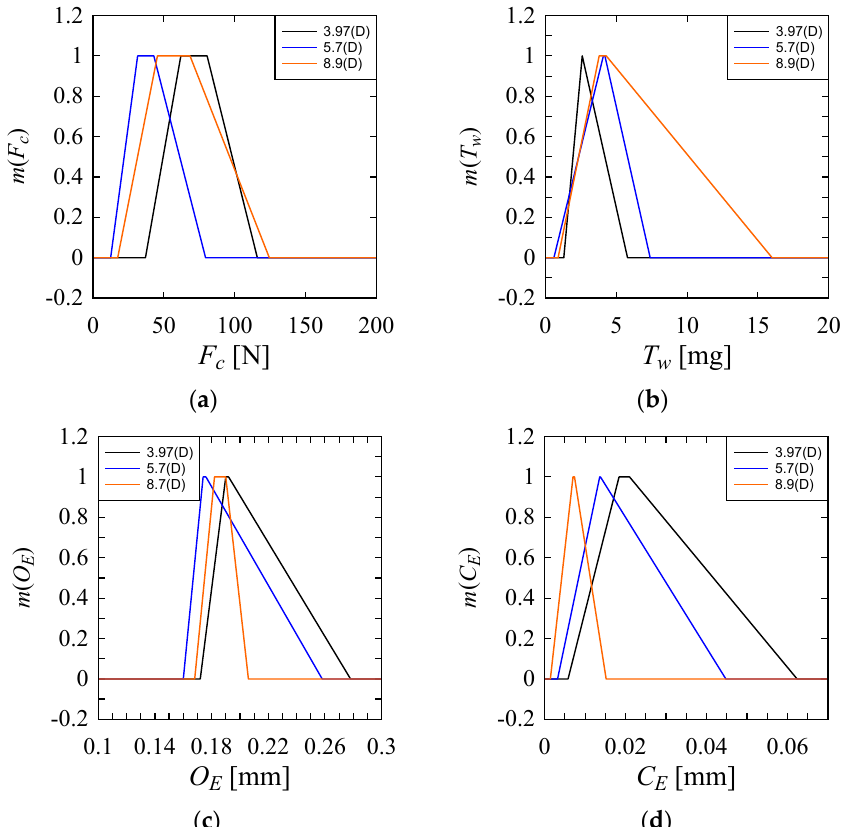
w is concerned, D = 3.97 mm is recommended. As far as a low O E or C E is concerned, D = 8.9 mm